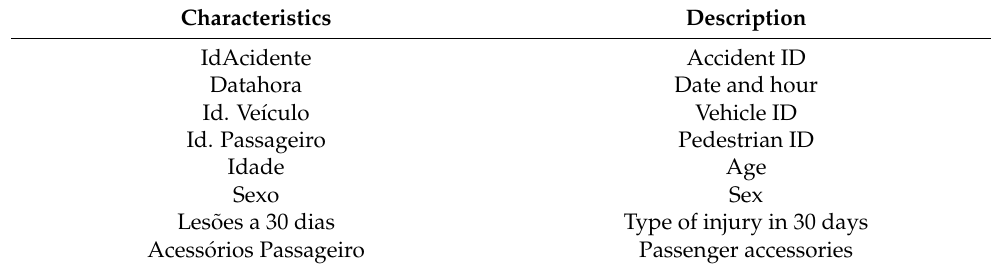
Table 5. Passengers’ data schema.